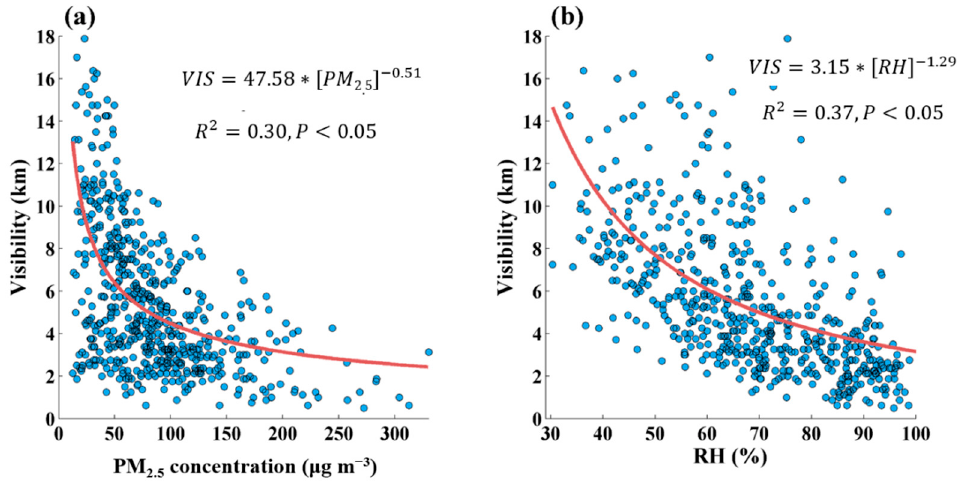
Figure 4. Scatterplots of ( a ) visibility and PM 2.5 as well as ( b ) visibility and RH in Nanjing during winter over 2013–2018 with the curves of the power function fitting equations.